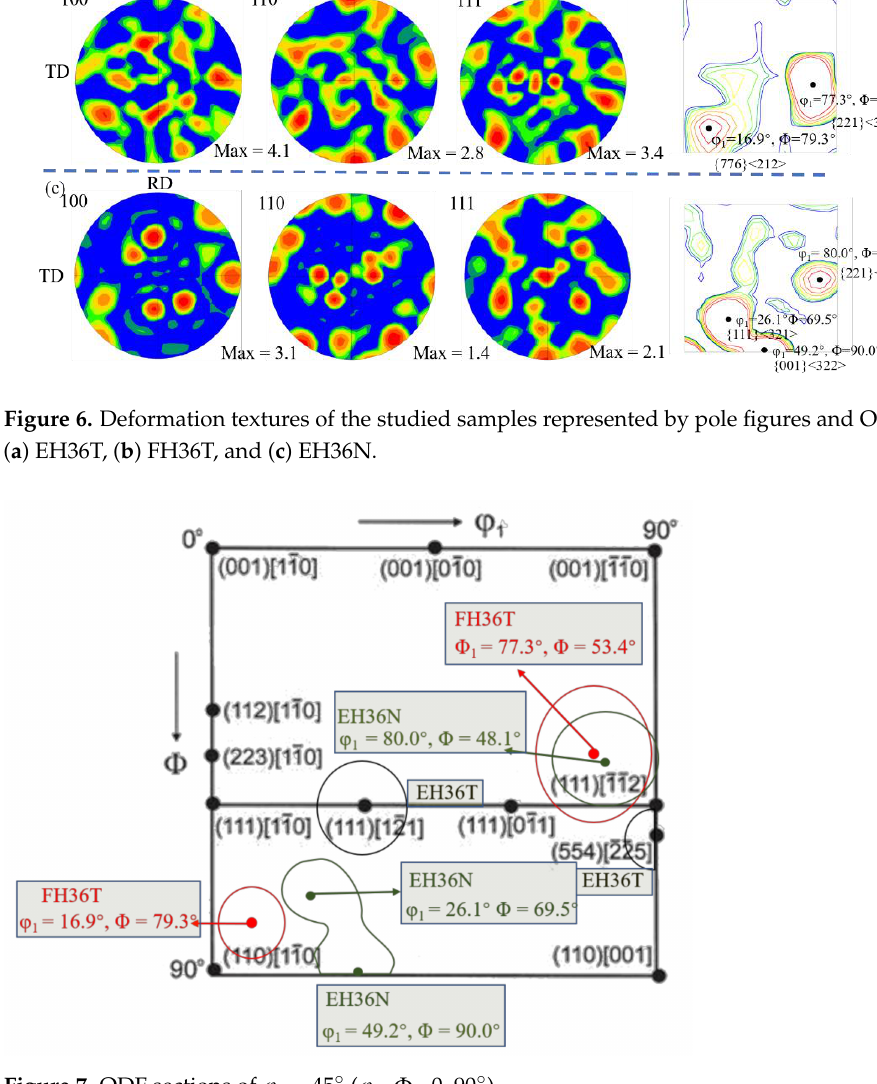
Figure 7. ODF sections of φ 2 = 45° ( φ 1 , 𝛷 = 0 – 90°).